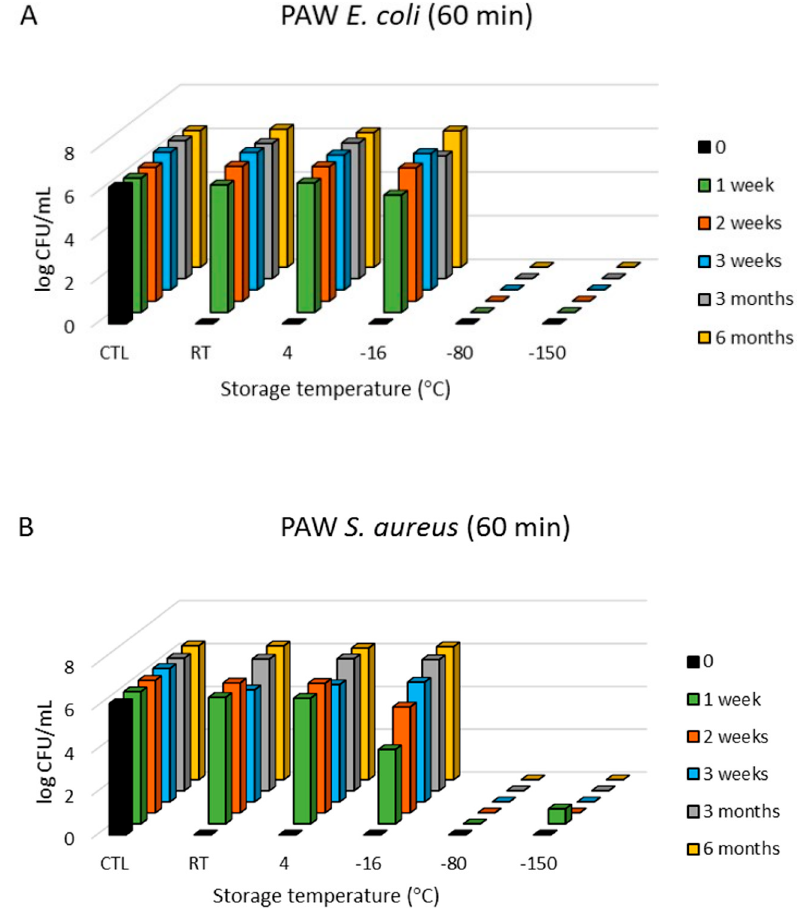
Figure 4. Microbial inactivation of E . coli and S . aureus at different contact times, treated with PAW stored at different temperatures for up to 6 months. (Set 4); standard deviations can be found in supplementary Table S3. ( A ) PAW E. coli (60 min), ( B ) PAW S. aureus (60 min).